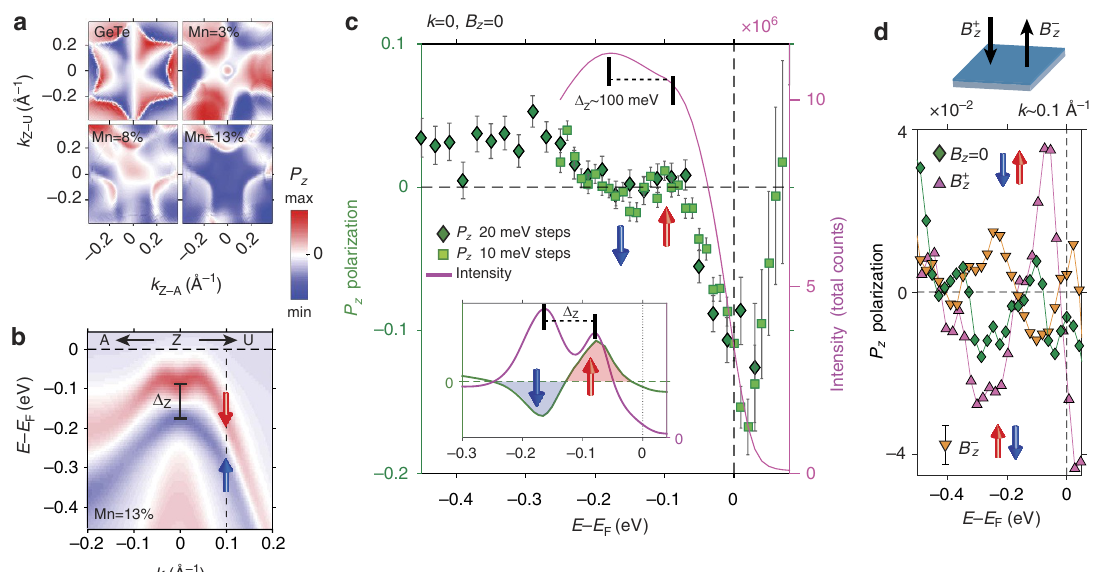
Figure 4 | Intrinsic and magnetized out-of-plane spin polarization: theory and experiment. ( a ) Calculated out-of-plane spin polarization in the photoemission final states for h n ¼ 22eV for GeTe below the Dirac point and for Ge 1 (cid:2) x Mn x Te with x Mn of 3, 8 and 13% below the Zeeman gap ( E 0.2eV binding energy). ( b ) Ge 0.87 Mn 0.13 Te initial-state calculations based on multiple scattering alloy theory along Z–A and Z–U. ( c ) Corresponding measured SARPES P z polarization in the Z-point visualized as energy-distribution curves in P z and total intensity measured across the Zeeman gap. The theoretical data from b is shown for comparison in the inset. The data points correspond to two independent experimental data sets with 20 and 10meVenergy steps (the smaller step size data is a verification of the larger one in a separate measurement, error bars are obtained from measurement statistics). The vertical arrows highlight the P z -wiggle resolved across the Zeeman gap D Z of the order of 100meV. ( d ) A comparison of P z -spin reorientation between intrinsic and (cid:3) (cid:4) and [111] B (cid:2) (cid:3) (cid:4) magnetized Ge 0.87 Mn 0.13 Te along the [ (cid:2) 1 (cid:2) 1 (cid:2) 1] B þ z z